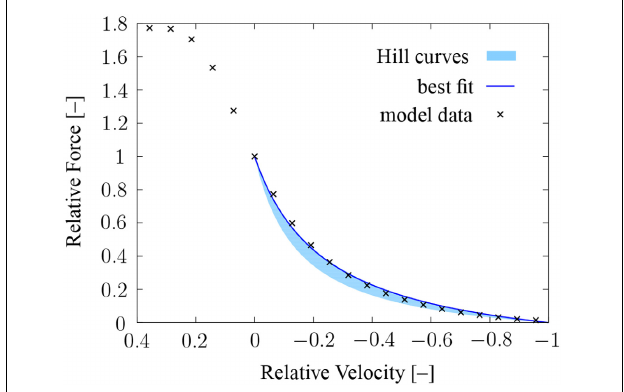
FIGURE 7 | F - v data computed using the multiscale chemo-electro- mechanical model. Shown are the F - v data of the model (black crosses), the corresponding fit of Hill’s hyperbolic relation ( κ = 0 . 241, blue line), and the region of typical muscle F - v curves (0 . 15 ≤ κ ≤ 0 . 25, light-blue shaded